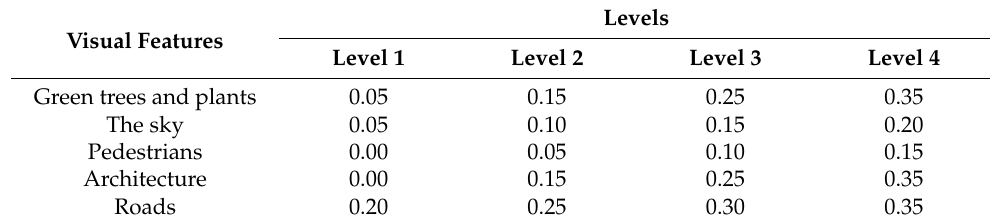
Table 2. Preference features and level.